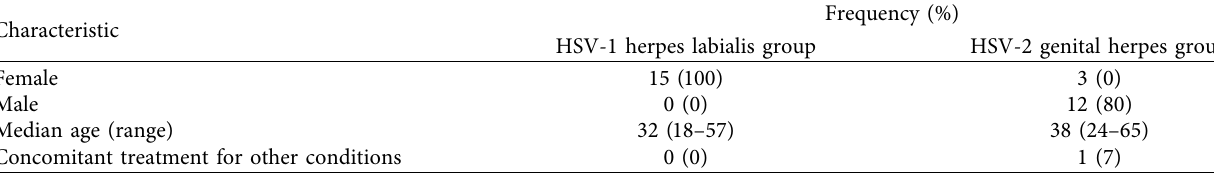
Table 2: Baseline characteristics of study participants.